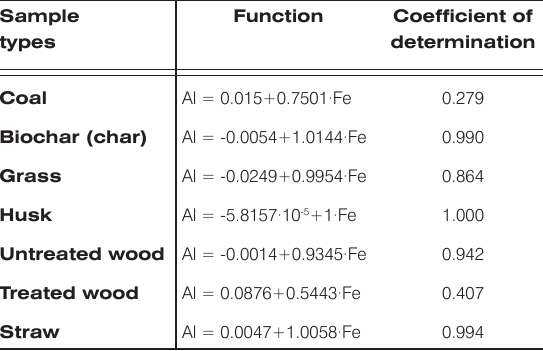
Table 4. Coefficient of determination and function of samples